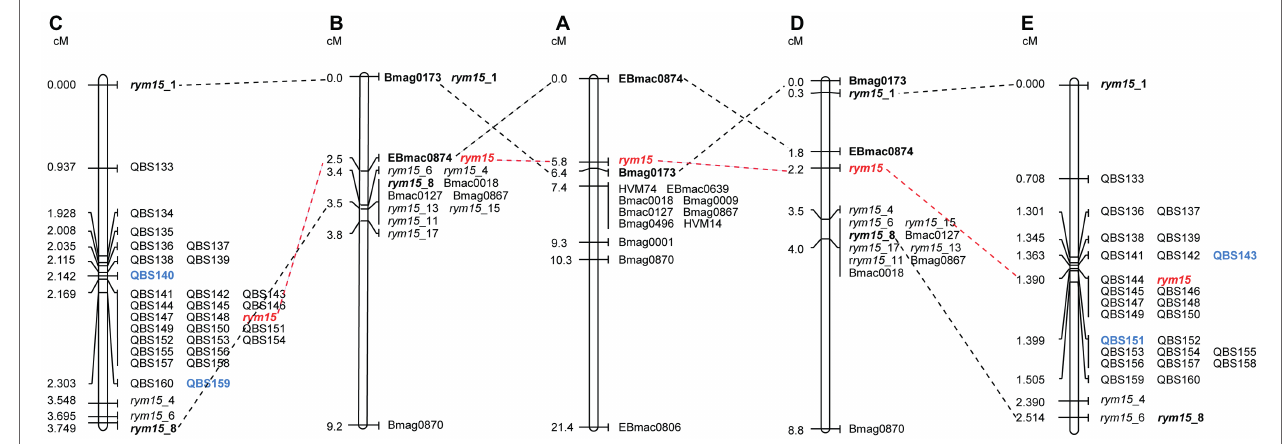
FIGURE 1 | Genetic maps of rym15 and collinearity of common molecular markers. (A) An initial genetic map of rym15 based on a set of 217 DH lines derived from the cross of Chikurin Ibaraki 1 × Plaisant (Le Gouis et al., 2004). (B) Medium-resolution map of rym15 based on a set of 180 F 2 lines derived from the population Igri×Chikurin Ibaraki 1 (Wang et al., 2021). (C) High-resolution map of rym15 based on a set of 139 F 4 segmental RILs in the population Igri ×Chikurin Ibaraki 1. (D) Medium-resolution map of rym15 based on a set of 342 F 2 lines derived from the population Chikurin Ibaraki 1 × Uschi (Wang et al., 2021). (E) High-resolution map of rym15 based on a set of 284 F 4 segmental RILs in the population Chikurin Ibaraki 1 × Uschi. The target gene rym15 is highlighted in red, the bold font indicates previous flanking markers from the initial and medium-resolution maps, while the new flanking markers identified from high-resolution mapping are shown in blue.